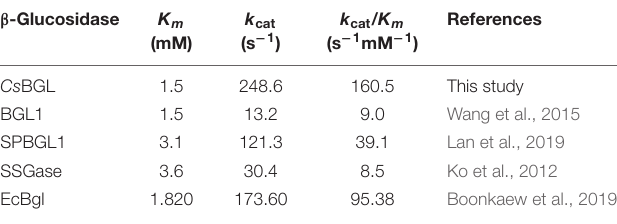
TABLE 1 | Kinetic parameters toward stevioside of reported β -glucosidase. β